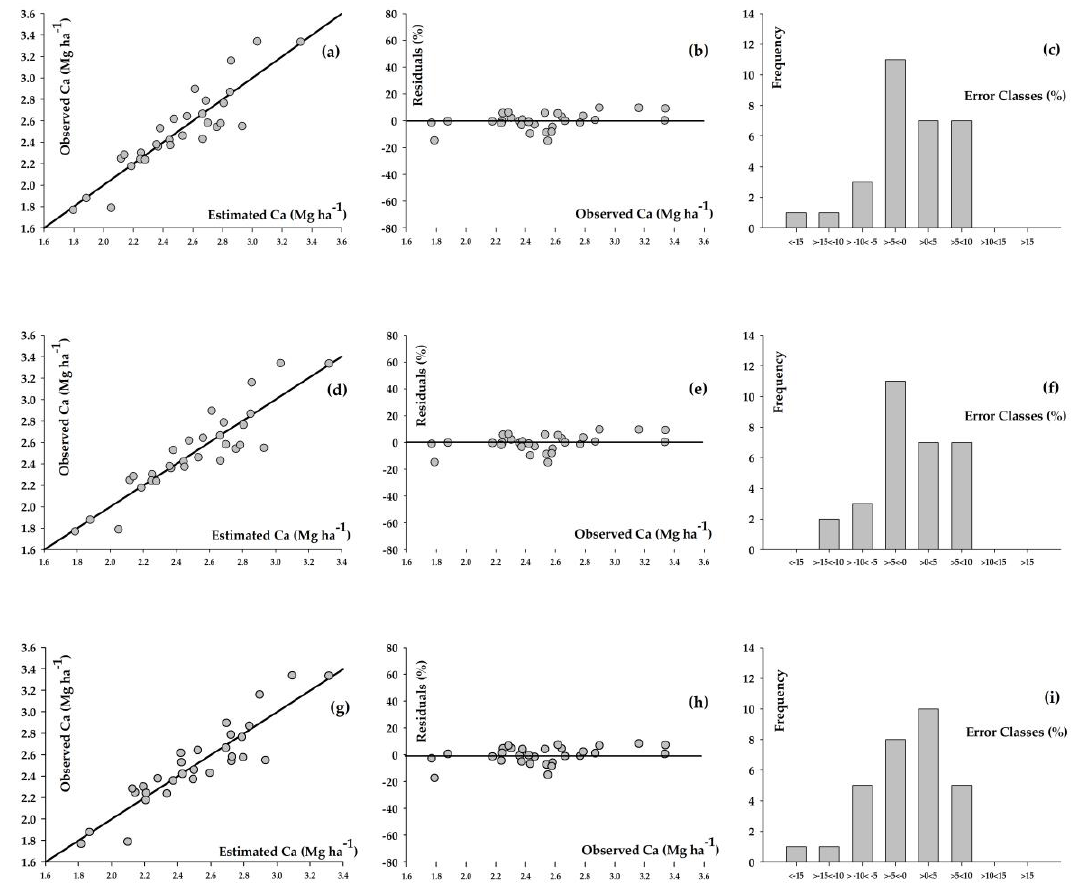
Figure 6. Dispersion of estimated value by observed value, dispersion of residues, and distribution in error classes obtained for the calcium adjustments (Mg ha − 1 ) using non-linear models, where ( a – c ) refer to the Richards model, ( d – f ) to the Weibull model, and ( g – i ) to the Schumacher–Hall model. Table 10. Statistical parameters of the non-linear models obtained in the adjustment of the amount of magnesium in the eucalypt stands.